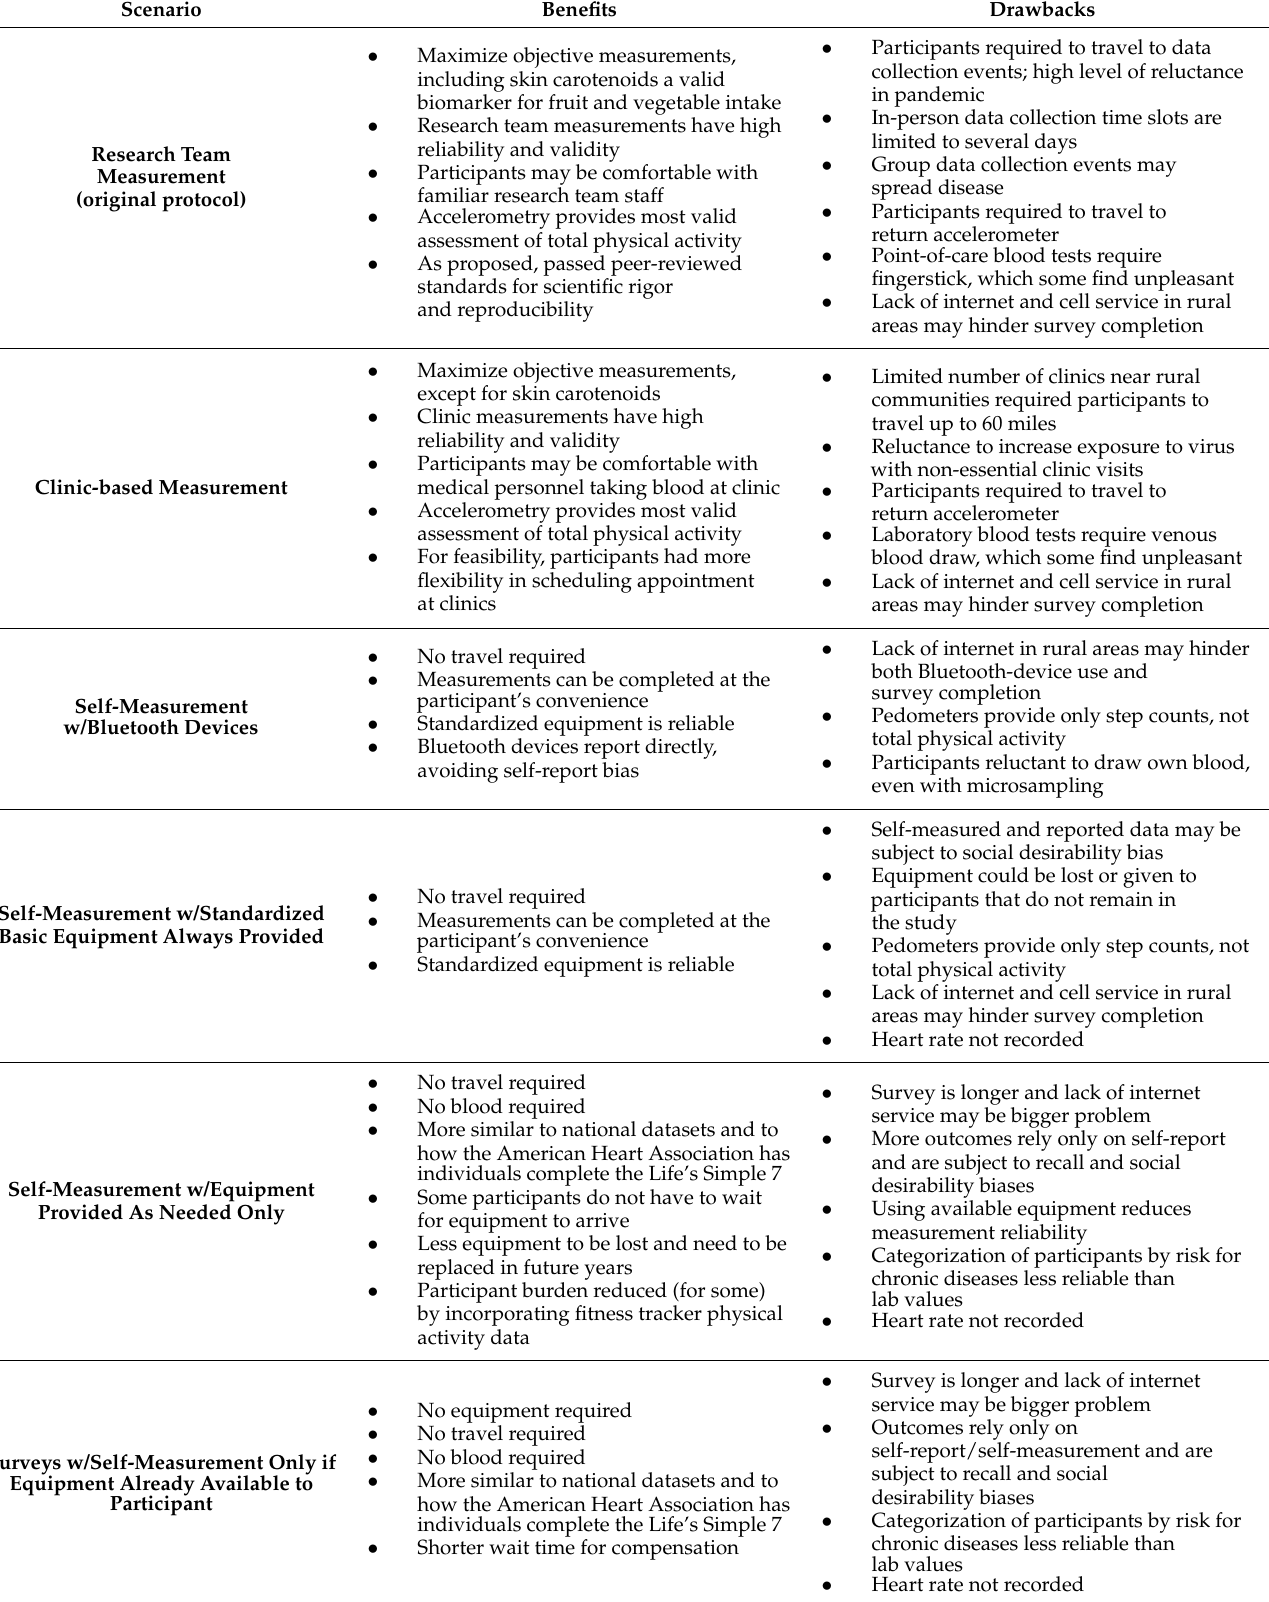
Table 3. Benefits and drawbacks of each